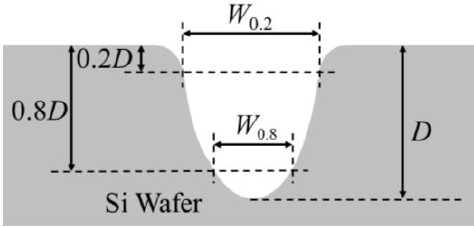
Figure 7. Three-dimensional profiles of treated flat Si wafer with He:CF 4 = 700:300 sccm and Ar:CF 4 = Figure 8. Schematic of groove profile. Figure 8. Schematic of groove 700:300 sccm at V pp = 9.8 kV: ( a ) t e = 5 min in the Ar/CF4 mixture; ( b ) t e = 5 min in the He/CF 4 mixture; ( c ) t e = 10 min in the Ar/CF 4 mixture; ( d ) t e = 10 min in the He/CF 4 mixture.